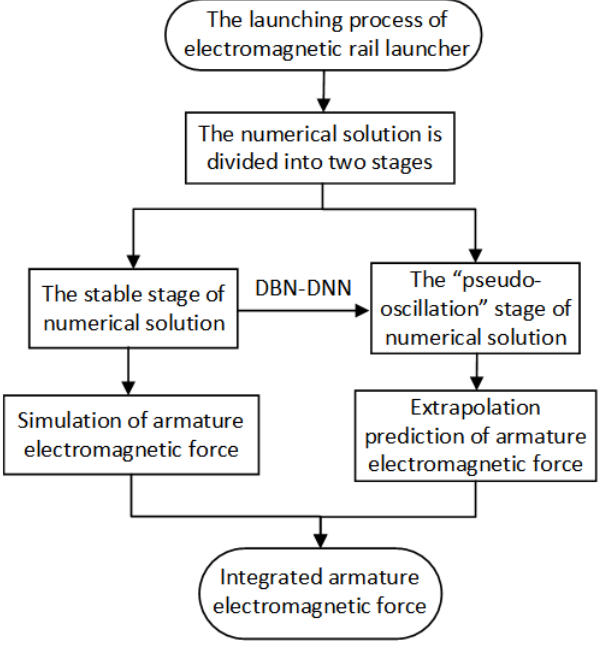
Figure 8. Flow chart of extrapolation prediction method.